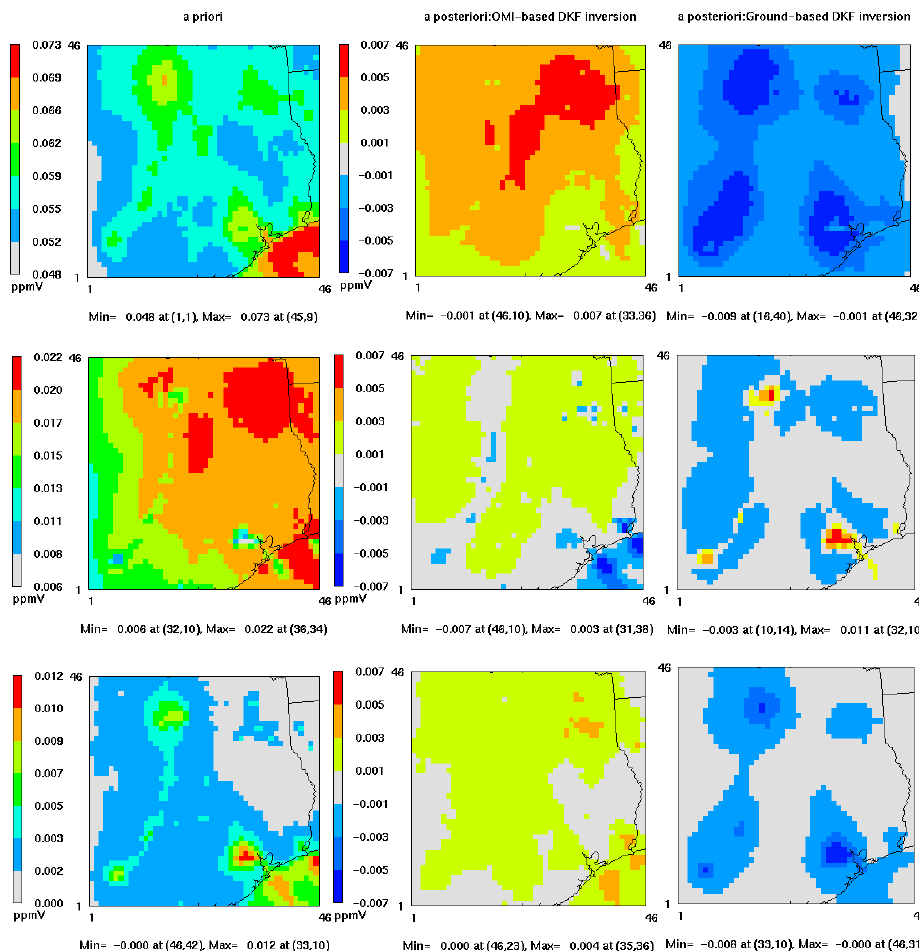
Fig. 7. Monthly 8h (10:00–18:00) averaged ground-level O 3 concentrations (top), O 3 sensitivity to NO x (middle), and O 3 sensitivity to VOC (bottom) for the a priori case (left column), and differences (a posteriori minus a priori) for the OMI-based (middle column) and ground-based (right column) DKF inversions in the June episode. The August–September episode shows similar